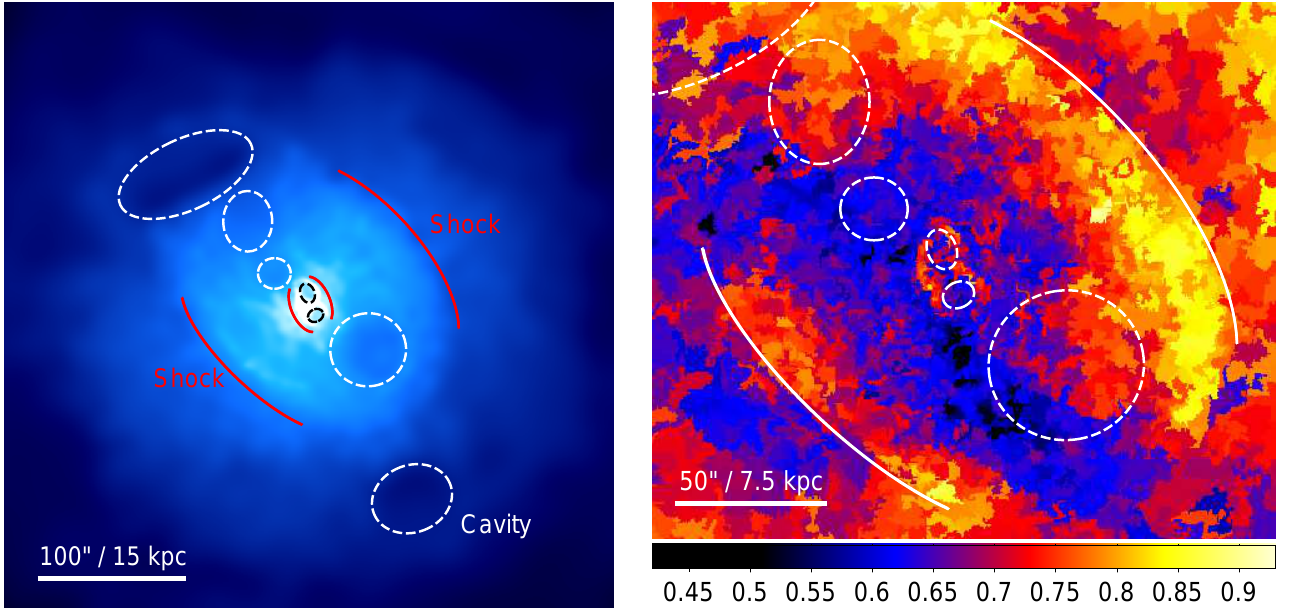
Figure 2. Cavities and shocks in the NGC 5813 galaxy group. The left panel shows an adaptively smoothed Chandra 0.5–2 keV image of the group, with cavities marked by dashed ellipses and two pairs of shock fronts by solid curved lines. The right panel shows a temperature map (in units of keV) with the cavities and outer shock fronts marked. Note the shock-heated gas (red and yellow) behind the outer shock fronts and in the shocked rims of the innermost set of cavities. Images drawn from the Chandra Early-type Galaxy Atlas